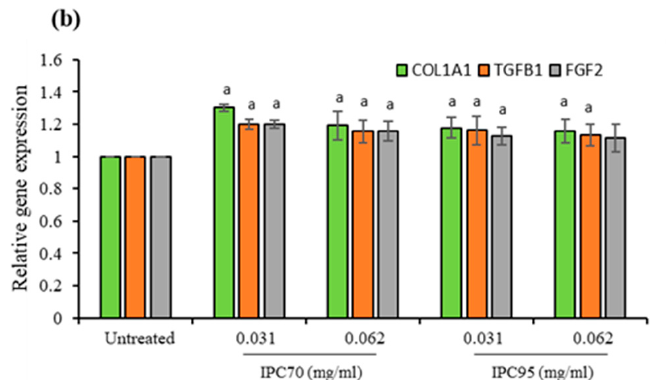
Figure 5. Effect of I. pes-caprae extracts on production of type I collagen and expression of COL1A1, TGFB1, and FGF2 genes. ( a ) Type I collagen production by CCD-986sk cells. ( b ) Expression of COL1A1, TGFB1, and FGF2 genes in CCD-986sk cells. Values are normalized to GAPDH and expressed relative to the values of untreated cells. The data are means ± SD from three independent experiments. The superscript letters ( a,b,c ) indicate significant difference at p < 0.05. ( a ) treated cells were compared with untreated cells; ( b ) rhTGF- β -treated cells were compared with IPC-treated cells; ( c ) IPC70-treated cells were compared with IPC95-treated cells.